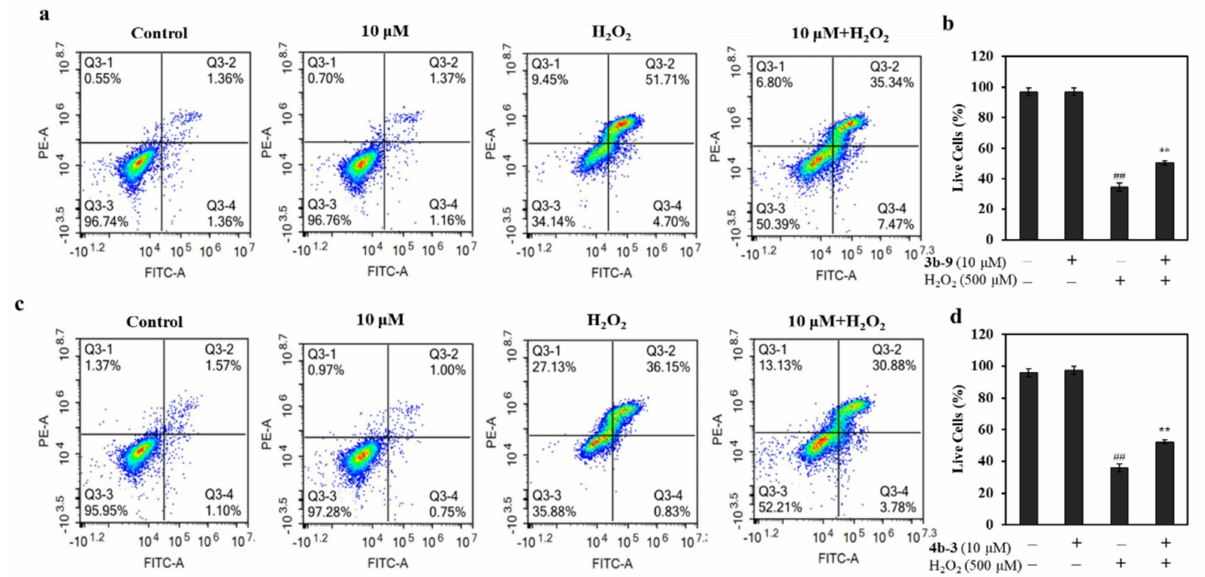
Figure 3. 3b-9 and 4b-3 alleviated H 2 O 2 -induced HaCaT cell damage. ( a ) In the presence or absence of H 2 O 2 , the ratio of apoptosis and viability of HaCaT cells treated with 3b-9 (10 µ M) were measured by flow cytometry. ( b ) The histogram depicted the proportion of living HaCaT cells after 3b-9 treatment. ( c ) In the presence or absence of H 2 O 2 , the ratio of apoptosis and viability of HaCaT cells treated with 4b-3 (10 µ M) were measured by flow cytometry. ( d ) The histogram depicted the proportion of living HaCaT cells after 4b-3 treatment. ## p < 0.01, versus control group; ** p < 0.01, versus H 2 O 2